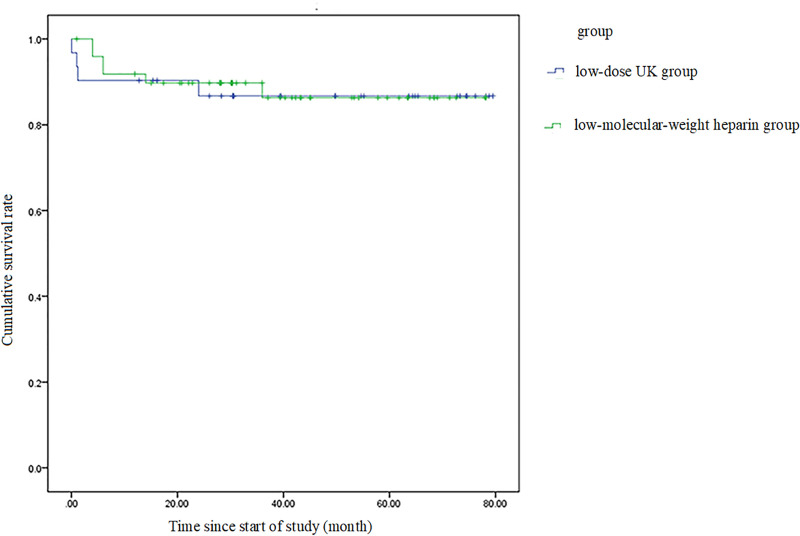
The Kaplan–Meier estimates of cumulative survival rate.Patients with intermediate-high-risk pulmonary embolism were treated with either low-dose urokinase (UK) plus low-molecular-weight heparin (LMWH) or LMWH alone; p=0.894, based on the log-rank test.